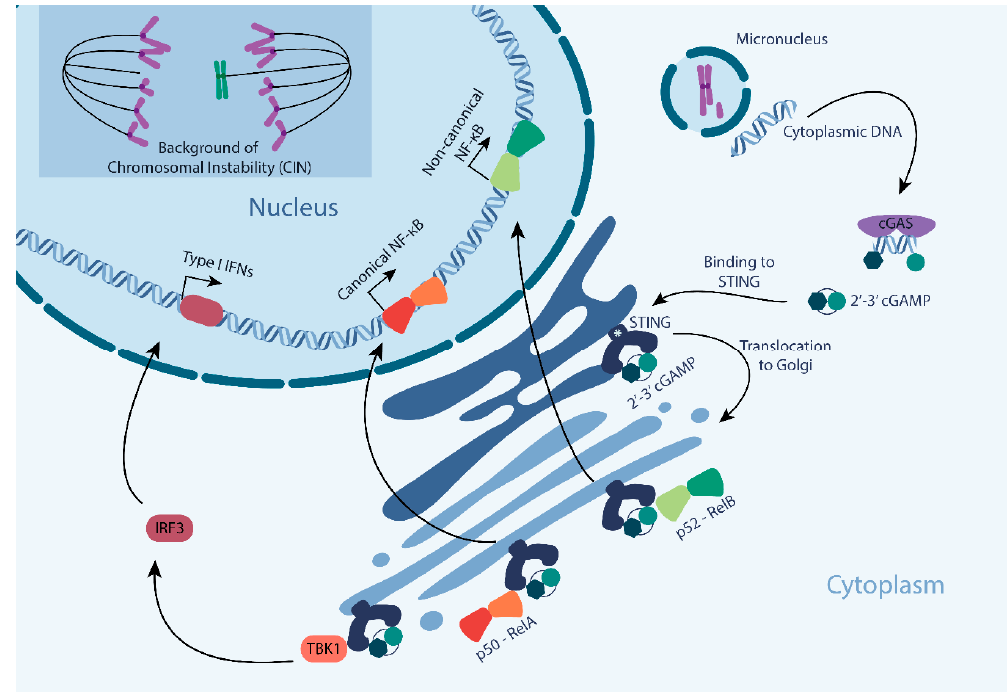
Figure 1. Cyclic GMP AMP synthase-STING (cGAS-STING) pathway signaling as activated by genomic instability. Cells with ongoing chromosomal instability (CIN) produce structures that contain genomic DNA, known as micronuclei. Upon the rupture of its membrane, dsDNA contained in a micronucleus is exposed to the cytoplasm and bound by cGAS. The binding of cGAS to dsDNA triggers the production of its secondary messenger, cGAMP that in turn binds and activates STING. Activated STING kinase translocates from the ER to the Golgi and phosphorylates its downstream targets, initiating (1) a TBK1-IRF3-type I interferon response, (2) a canonical NF-kB response, or (3) a non-canonical NF-kB response. * indicates stromal interaction molecule 1 (STIM1).